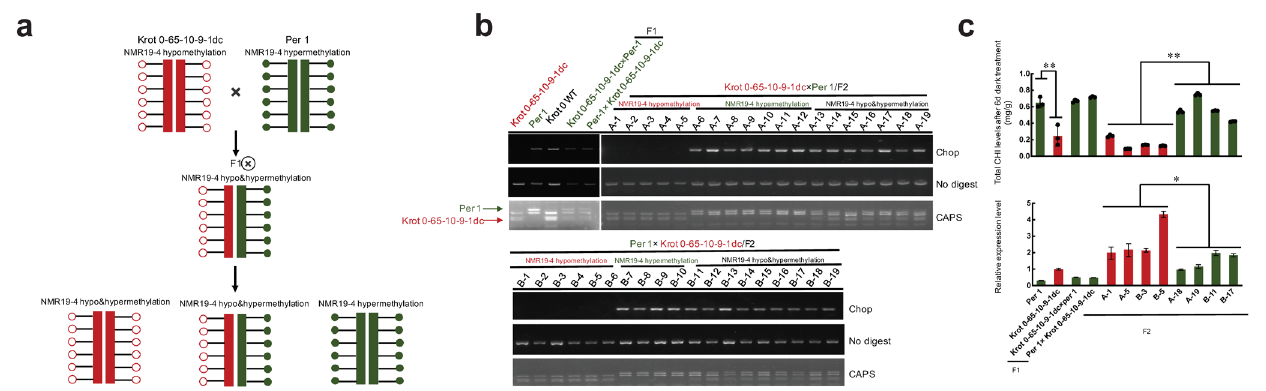
Figure 4. Demethylation-edited NMR19-4 loci can be trans-generationally transmitted by Mendelian inheritance in F1 hybrid and F2 segregation. ( a ) A schematic diagram of trans-generational transmission by Mendelian inheritance in F1 hybrid and F2 progeny. Filled green circles indicate hypermethylation and red empty circles indicate hypomethylation. ( b ) The methylation status of NMR19-4 was detected by Chop-PCR in F1 and F2 recombinant lines. The arrows on the left side of the gel photo indicate the specific alleles corresponding to the bands in the gel. The numbers of A1 to A19 and B1 to B19 represent the different individual plants, and all of them were used for Chop-PCR, CAPS, darkness-induced leaf senescence, and qPCR assays. CAPS: Based on the difference in the parental allele SNPs, the same primer was used for amplification, and the resulting PCR products were then digested with a restriction enzyme, and the specific inheritance allele in the progeny based on the distinguish of the digested band. ( c ) Quantification of chlorophyll content after 6 days of dark induction in the F1 and F2 recombinant lines by qPCR ( n = 3) (**, p < 0.01, t -test) and the expression level of PPH in F1 and F2 recombinant lines by qPCR (*, p < 0.05, t -test).